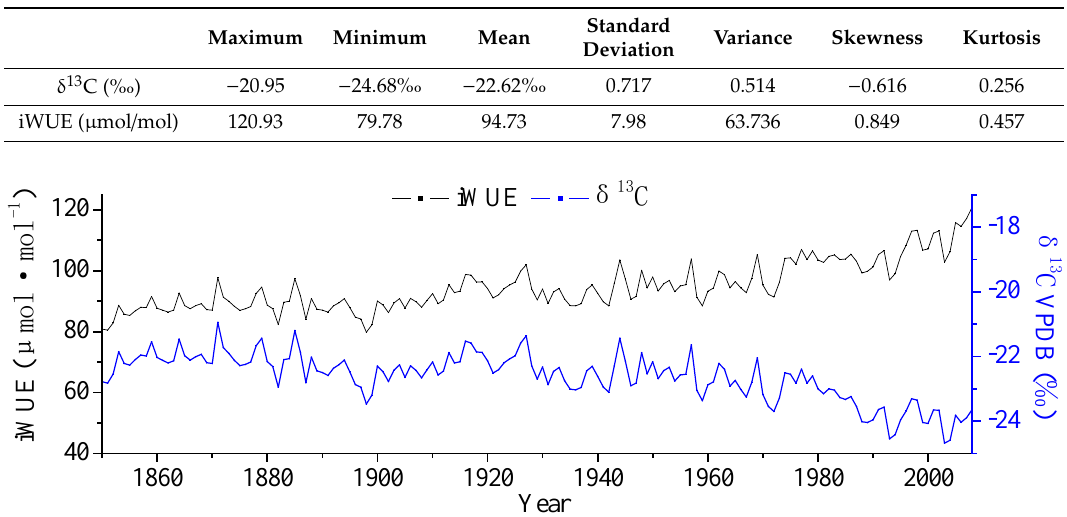
Figure 4. The δ 13 C and Intrinsic water-use e ffi ciency (iWUE) chronologies from 1850–2008 for the Sayram Lake Basin.